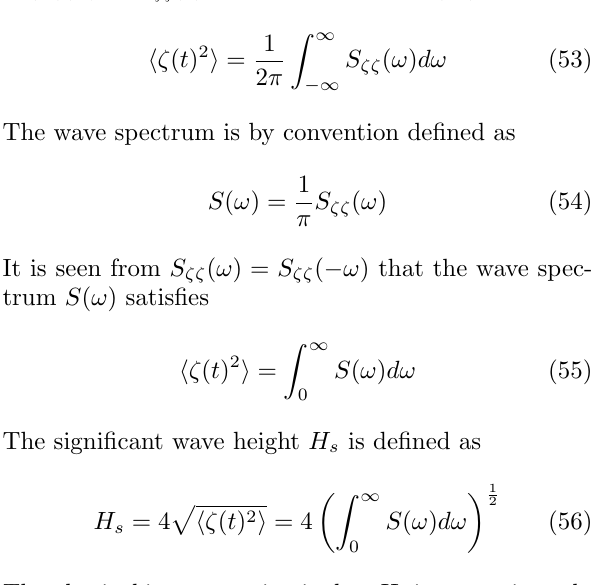
Figure 1: The twist t i = ˙ θ i L i with the line i − 1 ,i/i − 1 i − 1 /i − 1 (cid:126)l = ( (cid:126)z i − 1 , (cid:126)p i,i − 1 × (cid:126)z i − 1 i − 1 /i